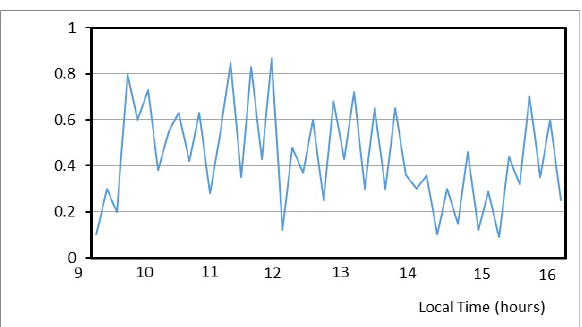
Fig. 4. Time series of structure refractive index constant C 2 took 2019 for line of 625.22 m, the weather was sunny and the tempera- n ture was in the range from 28 ◦ C to 32 ◦ C. The wind speed did not exceed 1.9